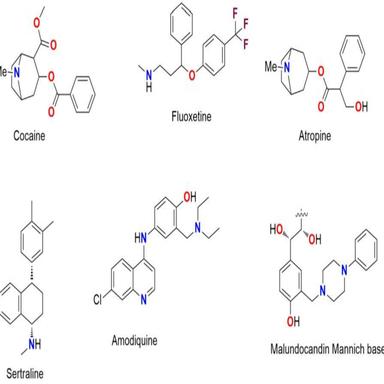
N-Mannich bases as valuable pharmaceutical ingredients.